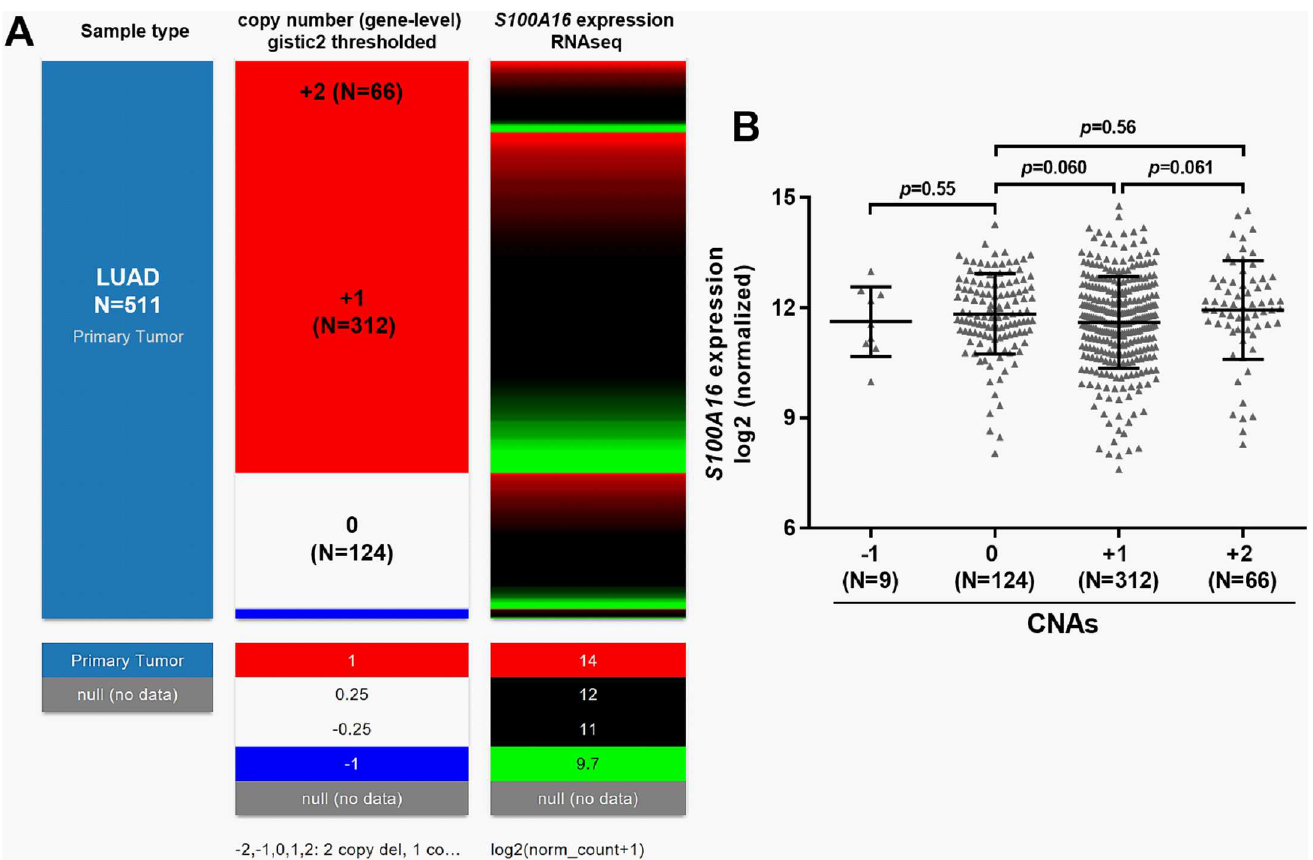
Fig 6. The association between S100A16 expression and its CNAs. A-B. Heatmap (A) and plots chart (B) of S100A16 DNA CNAs and its RNA expression. -2: homozygous deletion; -1: heterozygous loss, 0: copy-neutral; +1: low-level copy gain; +2: high-level amplification.